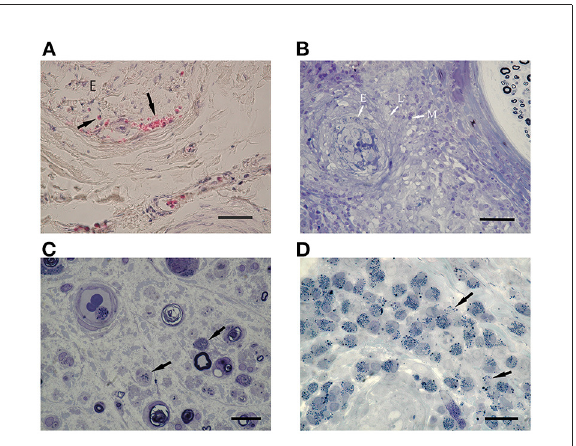
FIGURE3 Eosinophilic infiltration. (A) HE staining shows endoneurial infiltration of eosinophils (arrows) in a patient with iHES. (B) In patients with ANCA-positive EGPA, infiltrates are comprised of mixed eosinophils (E) and other cells (L: lymphocytes, M: macrophages). (C) In a patient with ANCA-negative EGPA, endoneurial eosinophils show decreased cytoplasmic granules and piecemeal degranulation (arrows). Intraluminal eosinophils are also observed (arrowhead). (D) In ANCA-negative EGPA, eosinophils infiltrating the vessel wall show degranulation (arrows). (B–D) EPON-embedded sections with toluidine-blue staining. Scale bars: 50 µ m (A,B) and 220 µ m (C,D) . ANCA, anti-neutrophil cytoplasmic antibodies; e, endoneurium; EGPA, eosinophilic granulomatosis with polyangiitis; HE, hematoxylin and eosin; iHES, idiopathic hypereosinophilic syndrome.